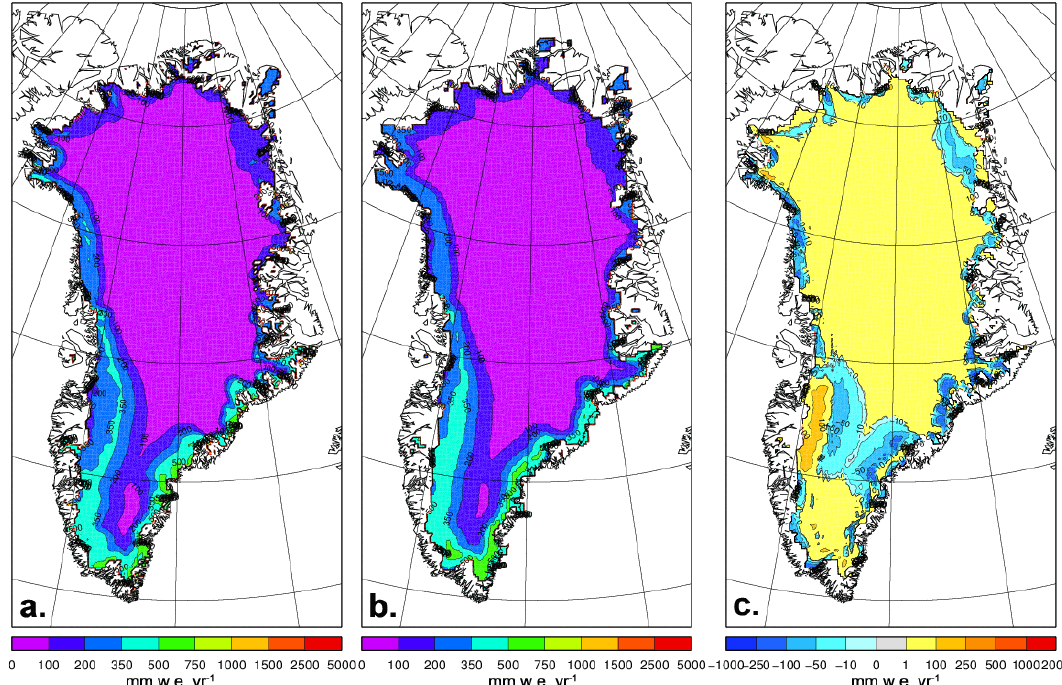
Fig. 1. Period (1958–2008) averaged anual sums of refrozen mass ( E r ) as modelled in (a) RACMO2, (b) MAR, and their difference (c) (MAR–RACMO2).